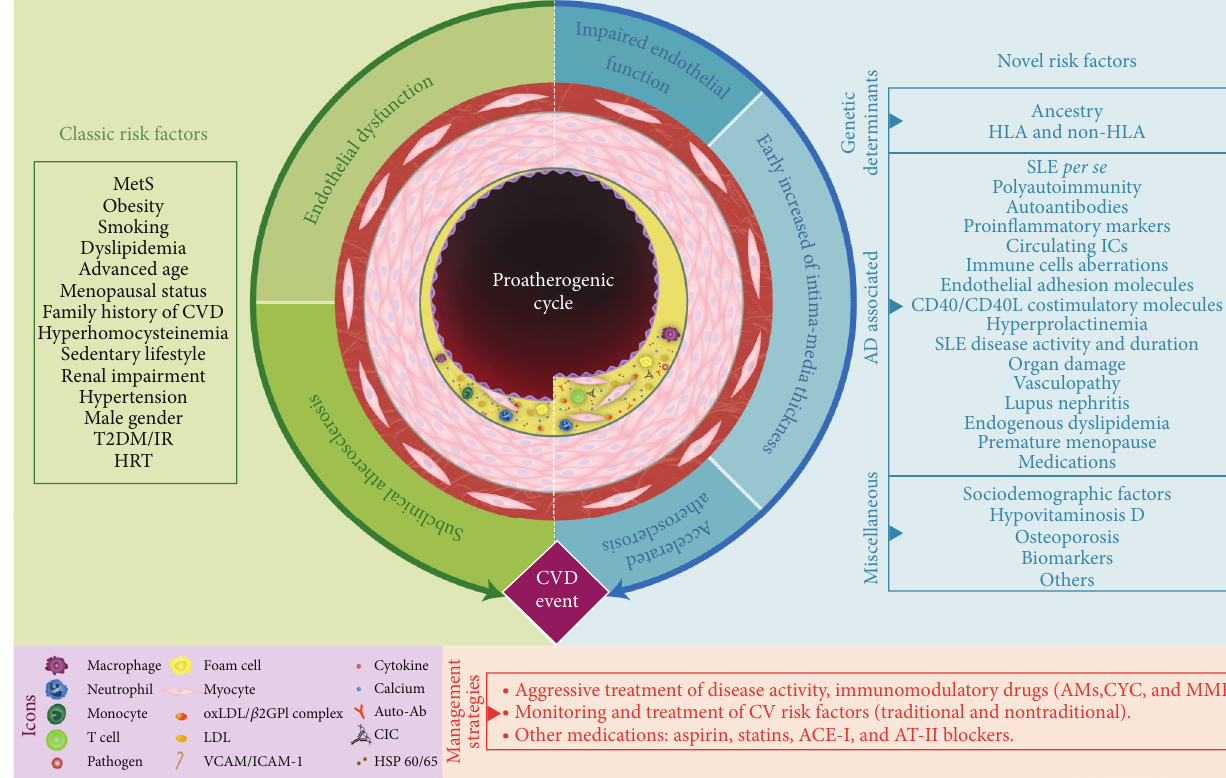
Figure2:Traditionalandautoimmune-relatedmechanismsofcardiovasculardiseaseinsystemiclupuserythematosus.Acomplexinteraction between traditional and disease-specific traits leads to premature atherosclerotic process. Several risk factors (left) have been described since The Framingham Heart Study, known as classic risk factors, which over time conduce to endothelial dysfunction, subclinical atherosclerosis, and CV event manifest. In the autoimmune setting (right), a broad spectrum of novel risk factors contribute to development of premature vascular damage. This damage is represented by impaired endothelial function and early increased of Intima-Media Thickness which are surrogates of the accelerated atherosclerosis process, which is perpetuated by a chronic proinflammatory milieu. The cornerstone of management of CV risk include an aggressive treatment of disease activity, the continuous monitoring and treatment of modifiable CV risk factors, as well as the use of other medications in order to diminish de CV burden. CVD: cardiovascular disease, SLE: systemic lupus erythematosus, MetS: metabolic syndrome, T2DM: type 2 diabetes mellitus, IR: insulin resistance, HRT: hormone replacement therapy, CIC: Circulating Immune complex, oxLDL/B2GPI complex: oxidized-low density lipoprotein/ 𝛽 2 glycoprotein I, HDL: high